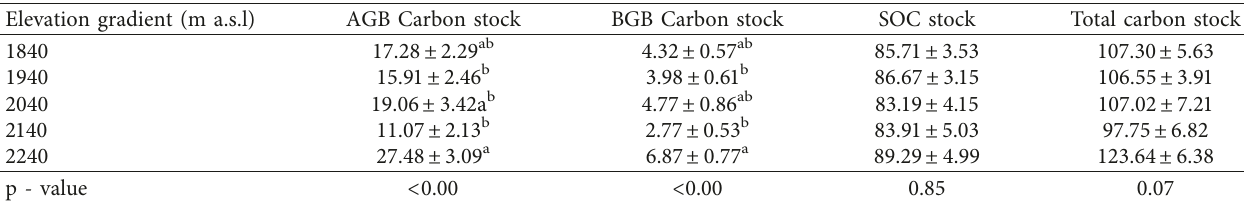
Table 6: Mean value of woody species AGB carbon stock (Mg ha − 1 ), BGB carbon stock (Mg ha − 1 ), SOC stock (Mg ha − 1 ), and total carbon stock (Mg ha − 1 ) along an elevation gradient of coffee-based agroforestry system. Elevation gradient (m